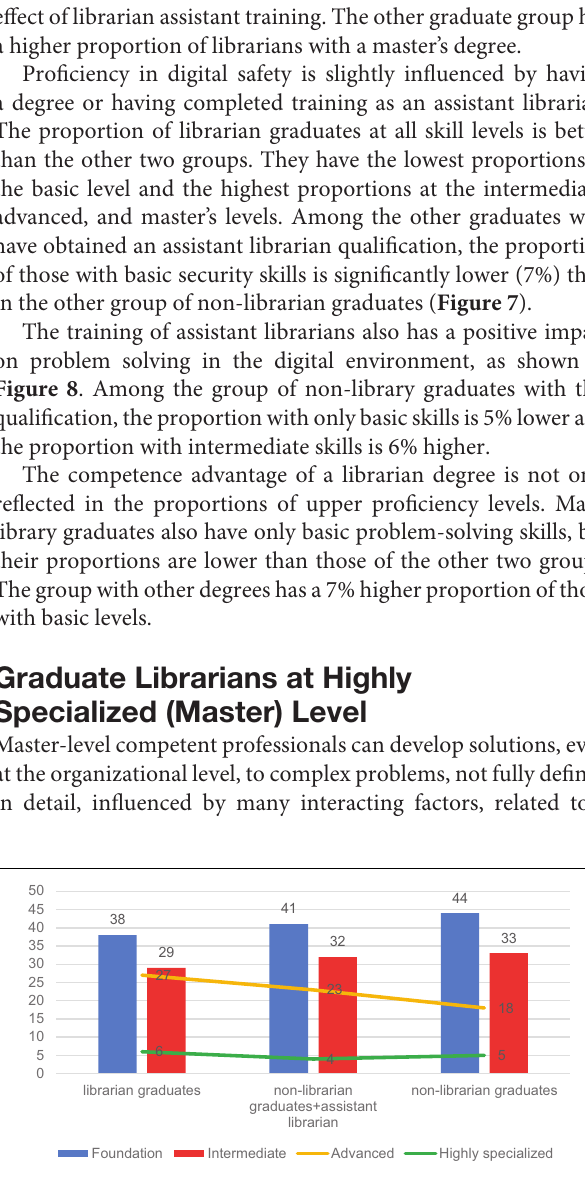
FIGURE 6 | Digital content creation. Diplomas and qualifications.